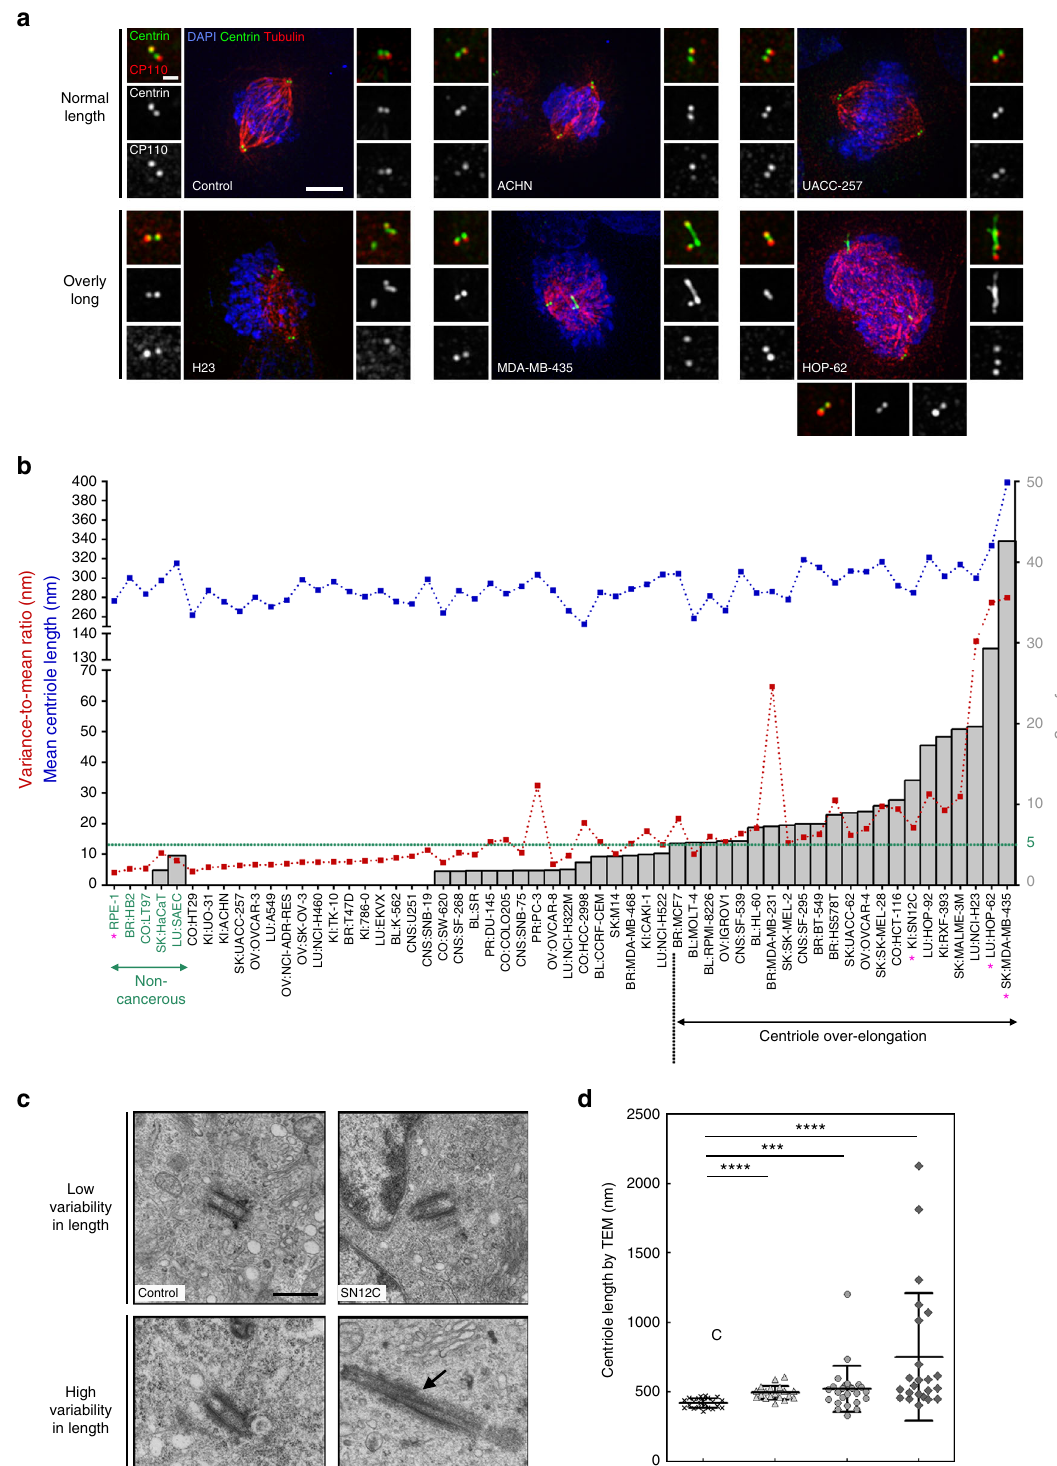
In addition, we observed that 22 cell lines display signi fi cant centriole over-elongation compared to non- cancerous cell lines (Fig. 3b and Supplementary Table 2). Cell lines with higher levels of centriole over-elongation belong to breast, skin and lung cancer (Supplementary Fig.